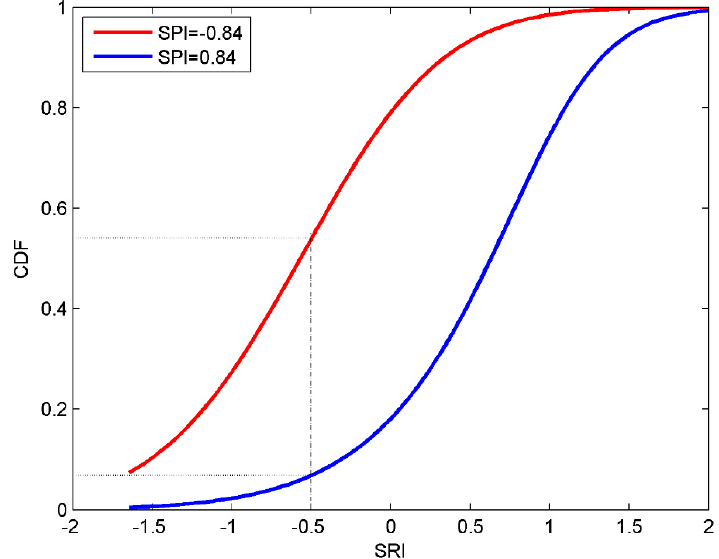
Figure 5. Conditional distribution of hydrological drought (represented with SRI) conditioned on the meteorological drought (represented with SPI).